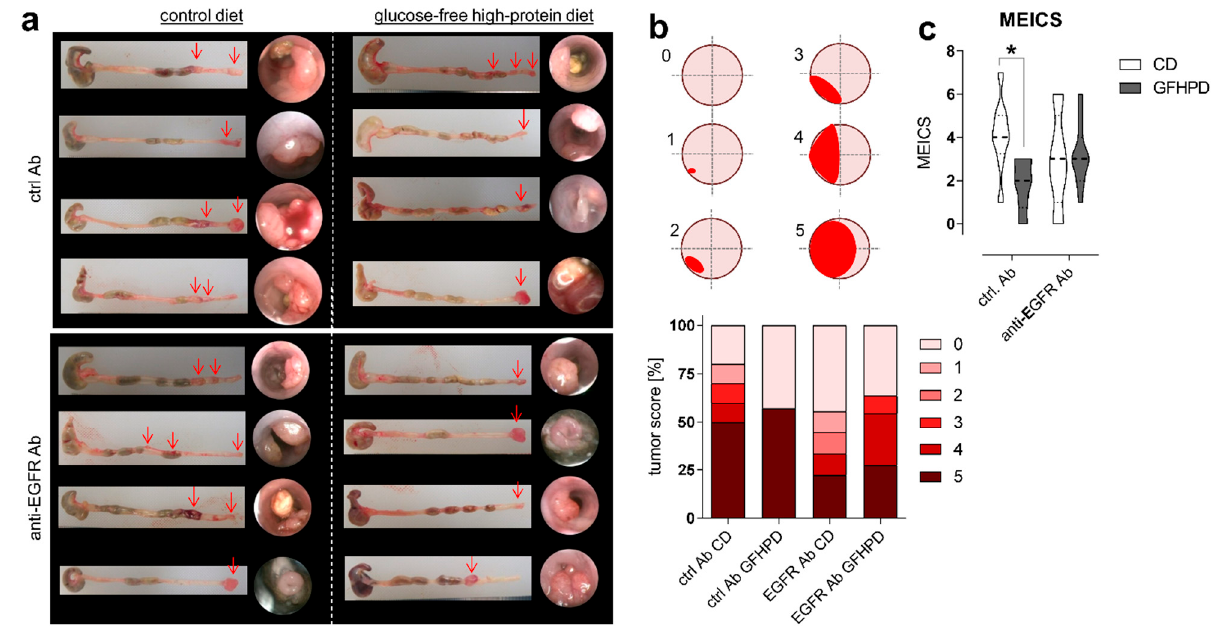
Figure 2. GFHPD displays comparable efficacy in CRC tumor load reduction in comparison to anti-EGFR Ab treatment. ( a ) Representative images ( n = 4 per indicated group) from colons collected from AOM/DSS-treated mice and respective endoscopic analysis at day 126. ( b ) Colorectal tumors were scored between 0 and 5 as described in [33] . Percentages for each tumor score were calculated per treatment group. ( c ) Murine endoscopic index of colitis severity (MEICS) was determined according to [33] . * p ≤ 0.05.